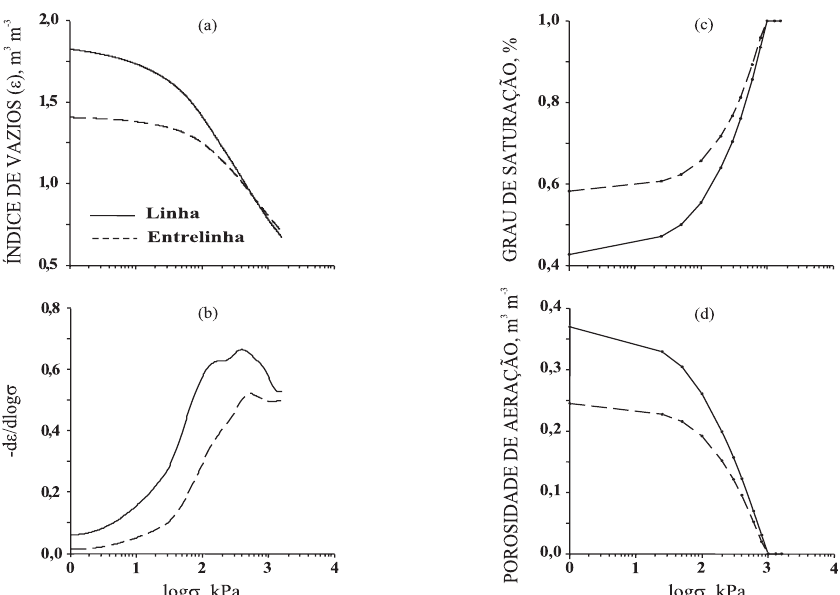
Figura 4. Curva de compressão do solo (a), sua primeira derivada (b) e variações do grau de saturação (c) e da porosidade de aeração (d) em função da pressão aplicada ( σσσσσ ) num Latossolo Vermelho distrófico de textura argilo-arenosa sob plantio direto, correspondente à camada de 2,5-5,0 cm, nas posições linha e entrelinha da cultura da aveia-preta. (N =